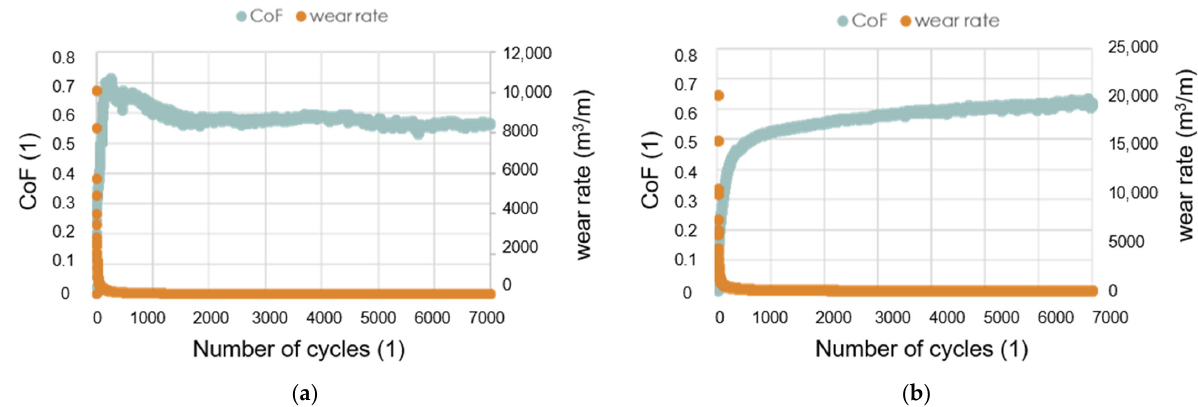
Figure 7. Experimental plots of the CoF and the wear rate of the SPS sinters tested in the dry sliding test with WC as a counterpart: ( a ) TiB 2 /10Ti 5 Si 3 1600 °C; ( b ) TiB 2 /20Ti 5 Si 3 1700 °C.